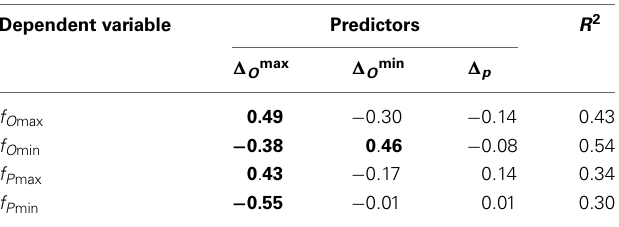
Table 3 | Results for the similarity analyses of the relative acquisition frequencies in Experiment